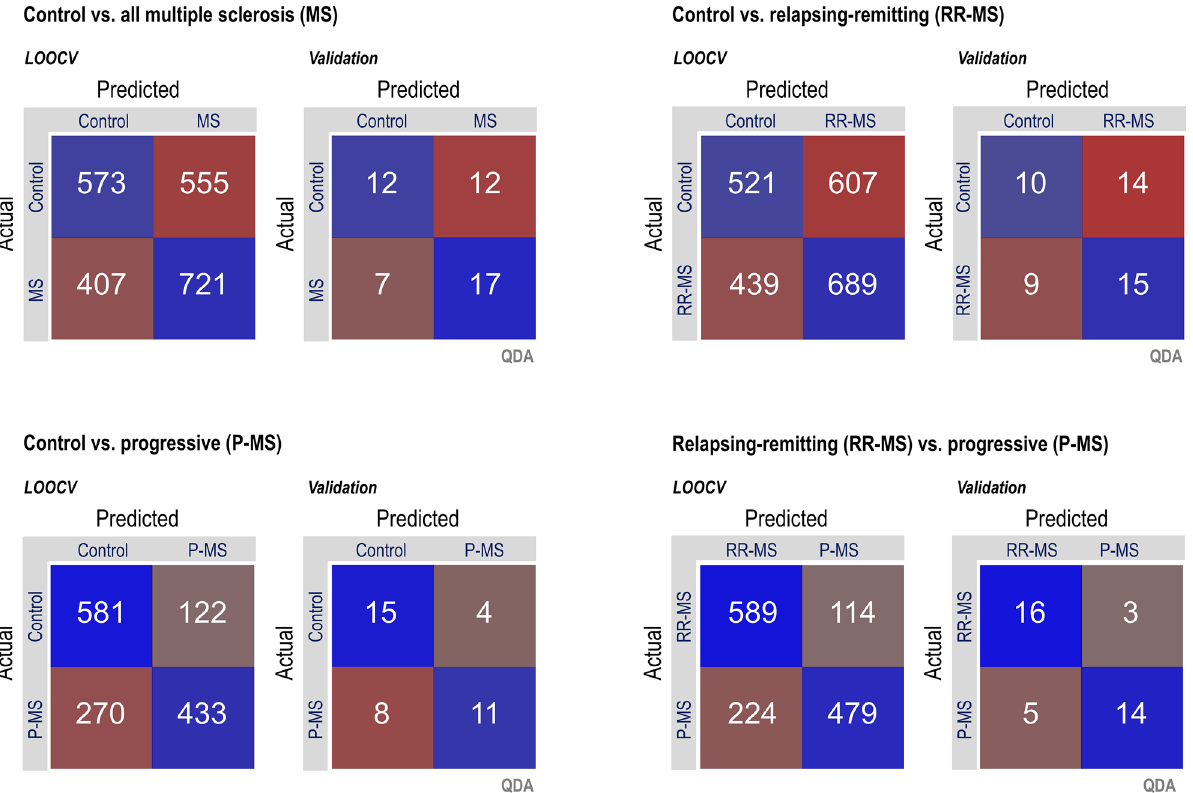
Figure 3. Confusion matrices for top-performing pipeline in each binary classification. Quadratic discriminant analysis (QDA) proved to be the top-performing classification algorithm by area under the receiver operating characteristic for all four questions, with higher validation sensitivity and specificity for classification of progressive patients than relapsing–remitting or all multiple sclerosis patients taken together, despite a smaller group size (progressive N = 19 versus relapsing–remitting N = 25 or control N = 24). LOOCV leave-one-out